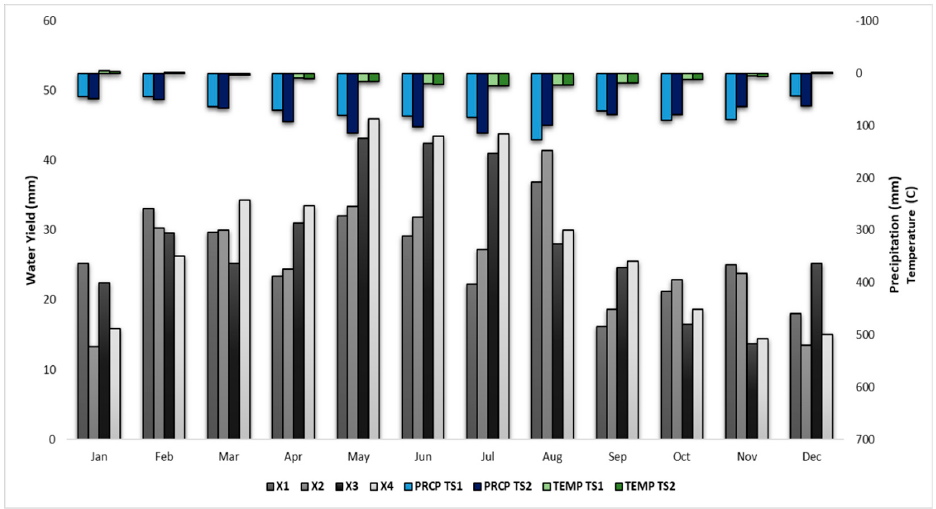
Figure 11. Monthly water yield change for the UWBDR watershed under different scenarios.